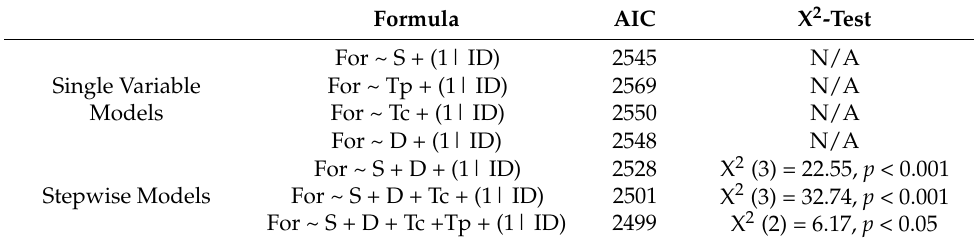
Table A3. Stepwise model selection for Aughinish. Details see Table